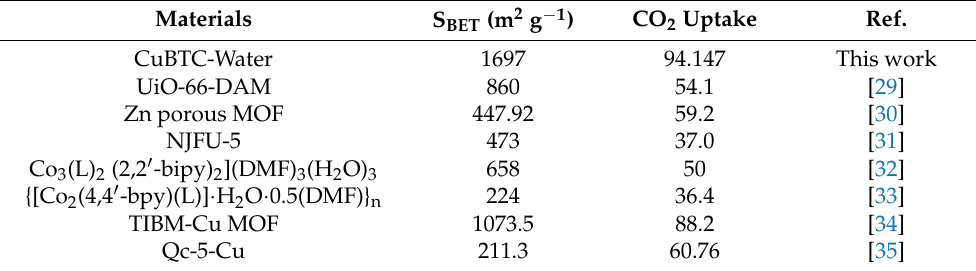
Table 1. Comparison of the performance of CuBTC-Water with other relevant materials reported in the literature.